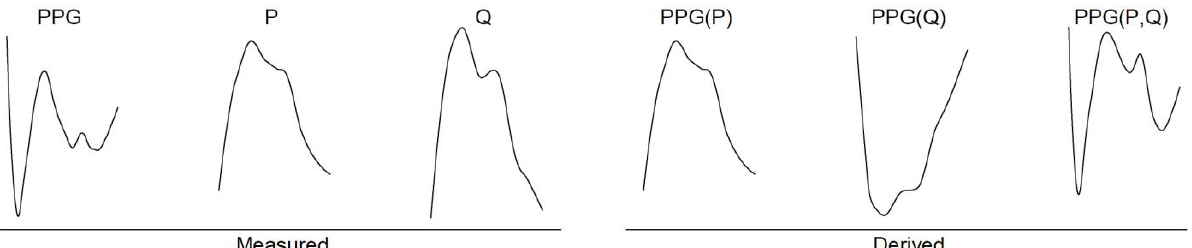
Figure 6. Example of an uncalibrated counter-phase pulse. Measured quantities: PPG (PPG), pressure (P), flow rate (Q). Derived quantities: prediction based only on pressure (PPG(P)), prediction based only on flow rate (PPG(Q)), prediction based on pressure and flow rate (PPG(P,Q)). All waveforms are uncalibrated. The PPG appears to be in counter-phase with pressure and the two waveforms share no similarities. Contrary to the prediction based only on pressure, the prediction based on pressure and flow rate PPG(P,Q) reproduced these counter-phase pulses.